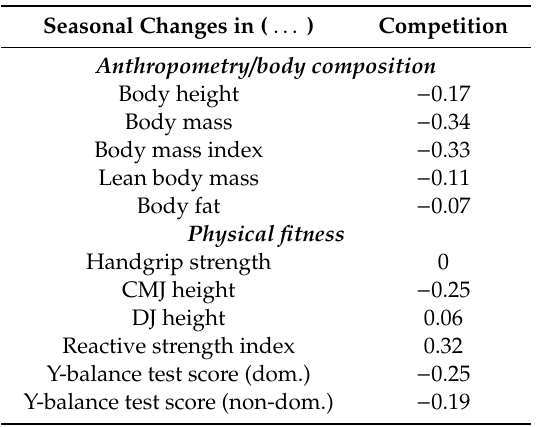
Table 3. Correlation between seasonal changes in anthropometry / body composition and physical fitness, and success in main competition in young male and female judo athletes. Seasonal Changes in ( ... )